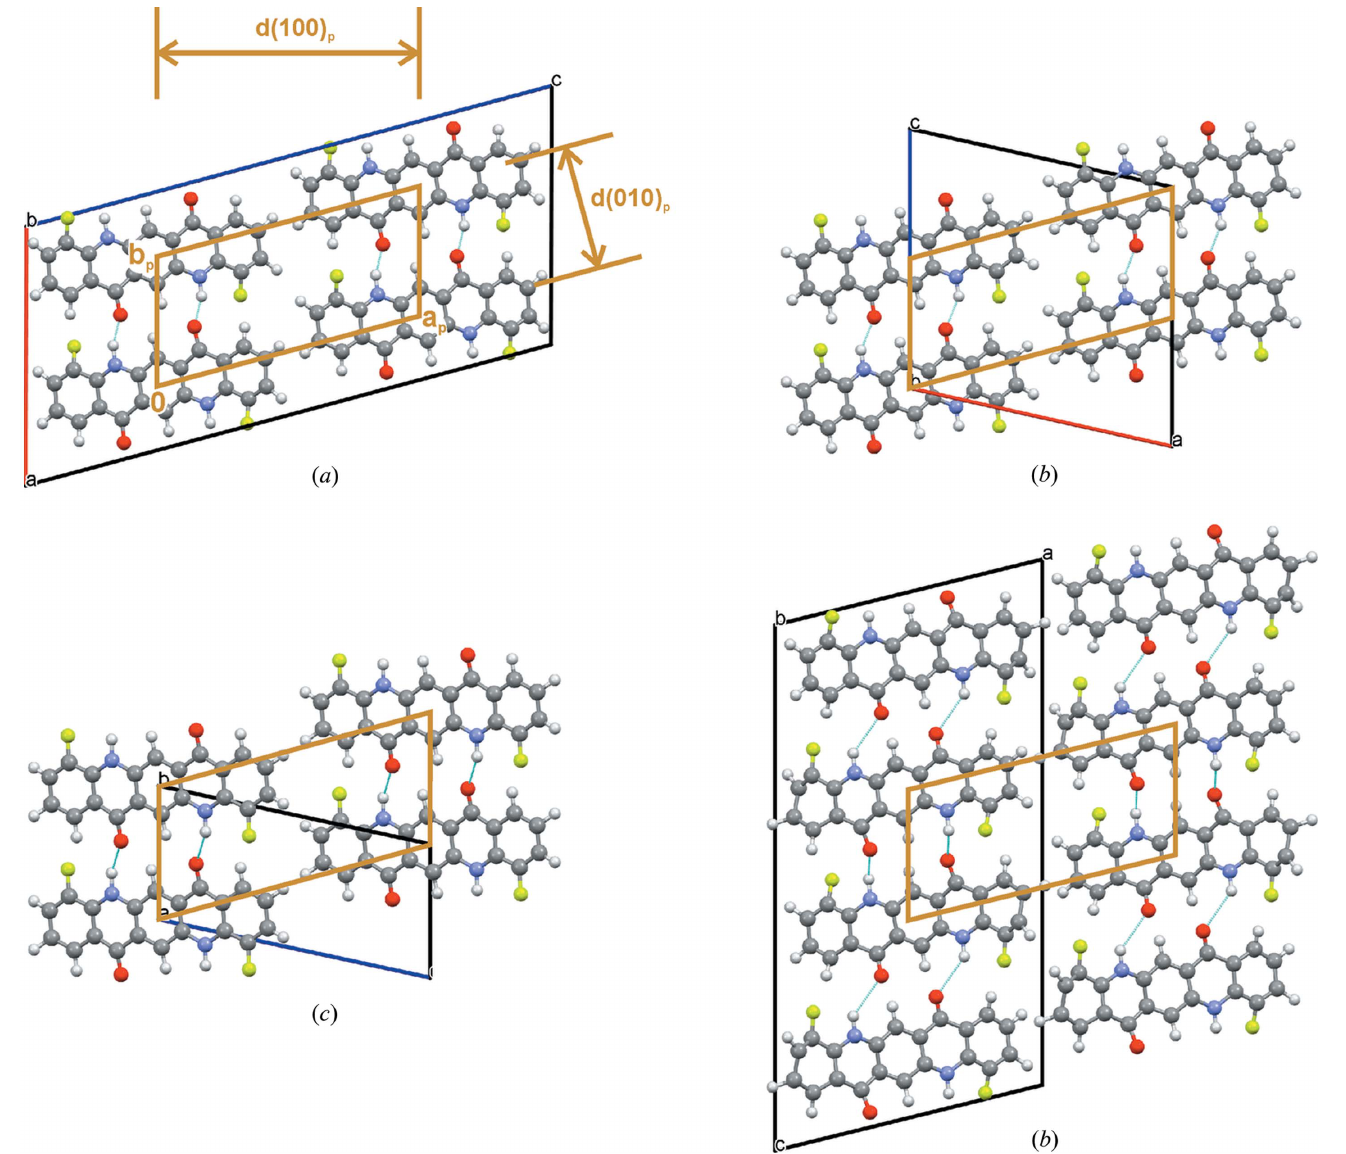
Figure 6 Structures A–D. Arrangement of the molecular stacks. Viewed along the stacking direction. The brown parallelogram marks the unit cell of the two- dimensional parallelogram pattern formed by the stacks, regardless of the orientation of the molecules within the stacks. This unit cell is similar for all structures. The net plane distances d (100) p and d (010) p of this unit cell are also